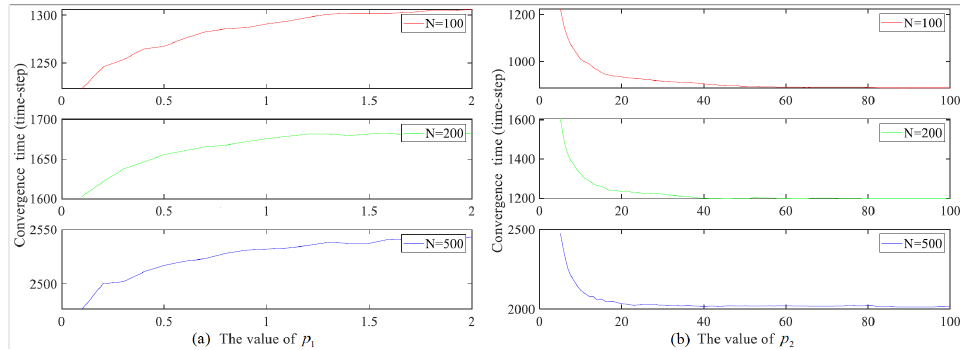
Figure 5. The performance of different group with different layer weighting parameter. ( a ) Different values of p 1 with p 2 = 5. ( b ) Different values of p 2 with p 1 = 0.01.